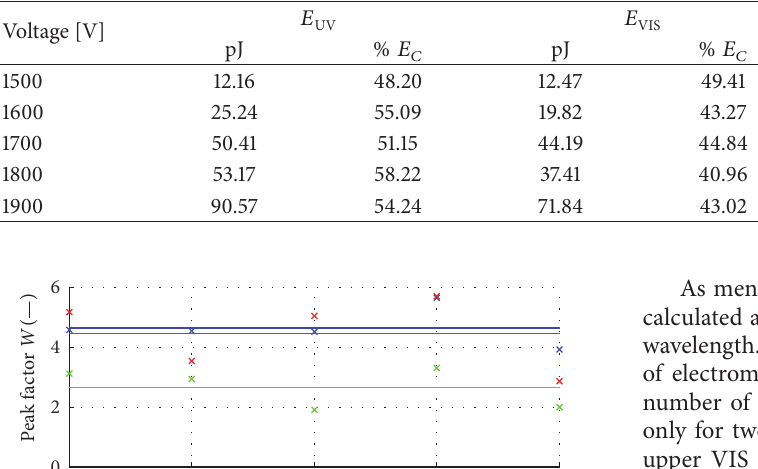
Table 3: The calculated electromagnetic radiation energy values.